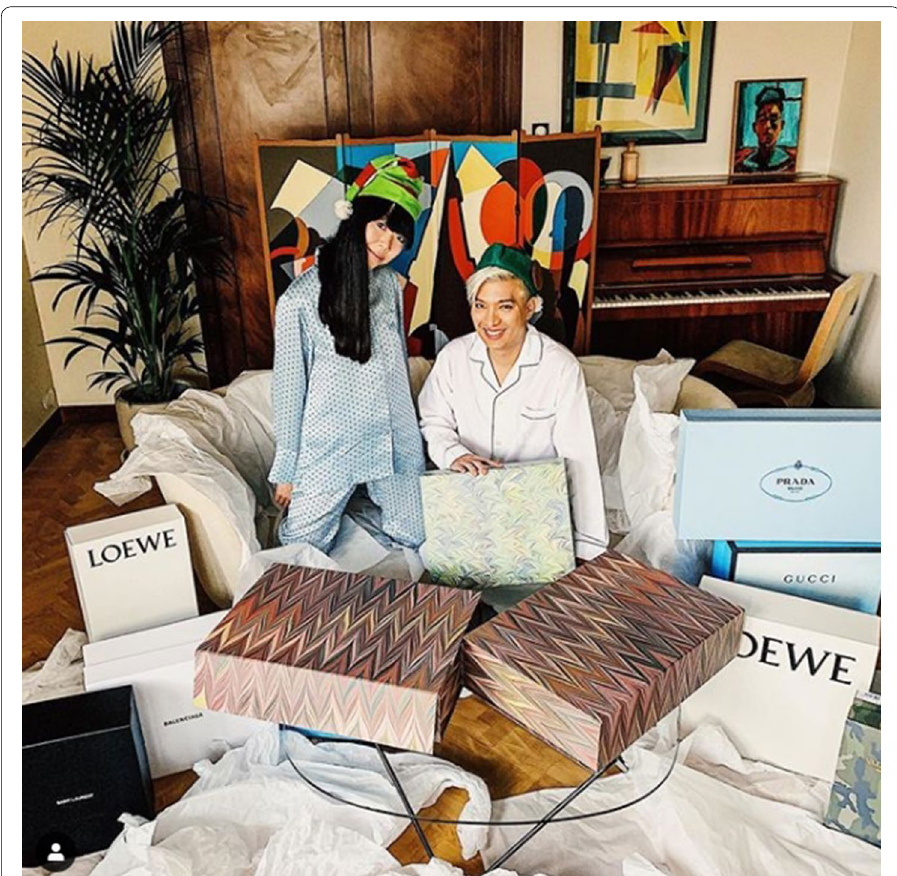
Fig. 10 Xmas spirit early with @matchesfashion. https ://www.insta gram.com/p/BqYB5 E7BVf C/. Accessed 20 September